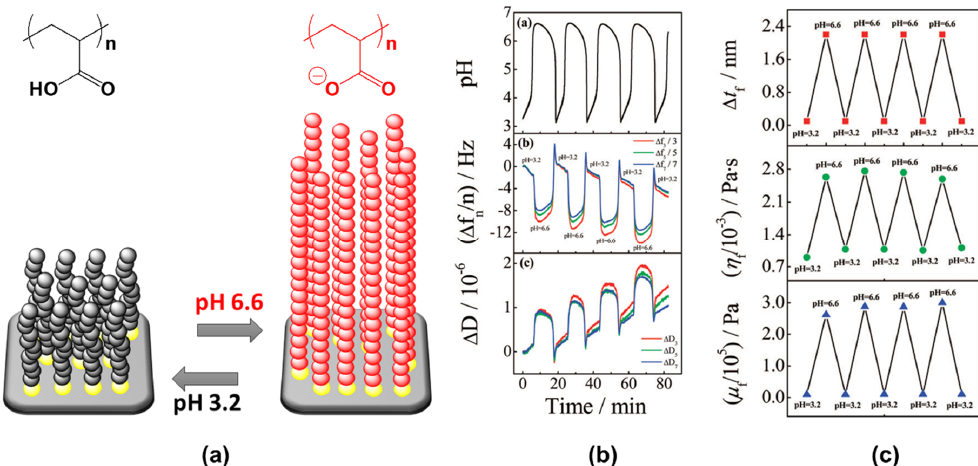
Figure 5. ( a ) Schematic representation of pH-responsive poly(acrylic acid) brushes. ( b ) The observed shifts in frequency and dissipation caused by pH oscillations. ( c ) Deducted changes in brush thickness, shear viscosity and elastic shear modulus. Reproduced with permission from [84], American Chemical Society, 2008.